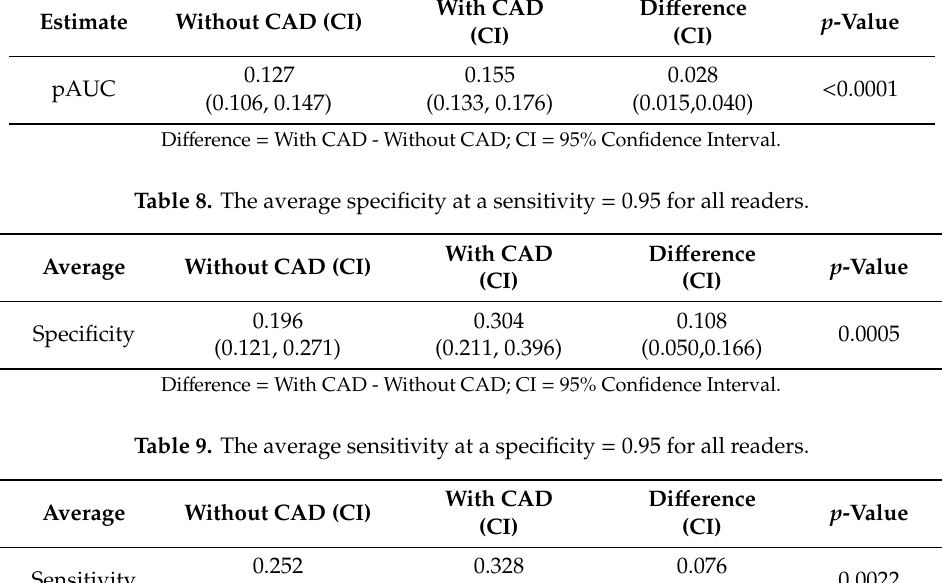
With CAD Di ff erence (CI) (CI)